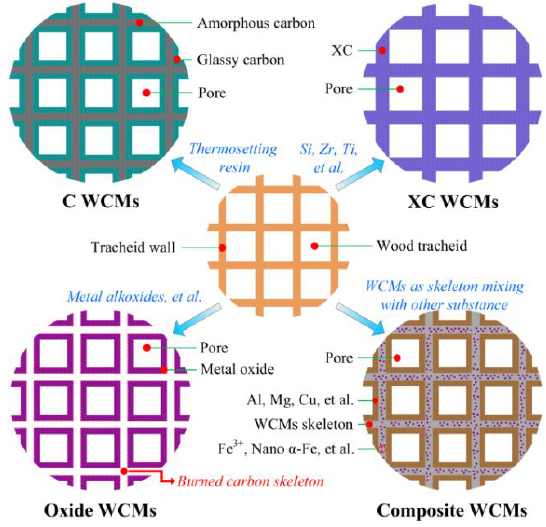
Figure 1. Schematics diagram of the microstructure of WCMs.